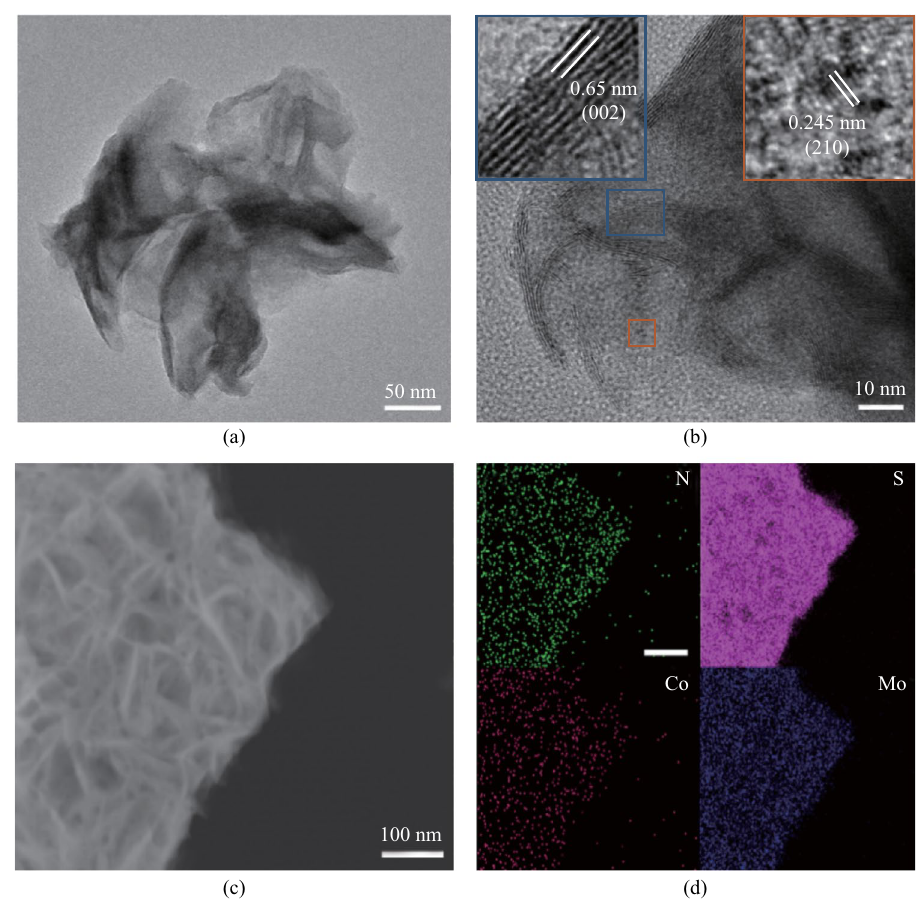
Fig. 4 a and b TEM images of the MOS/COS/CC-6 h electrocatalyst. Insets are the local HRTEM images. c and d STEM-EDS elemental maps of N, S, Co and Mo of MOS/COS/CC-6